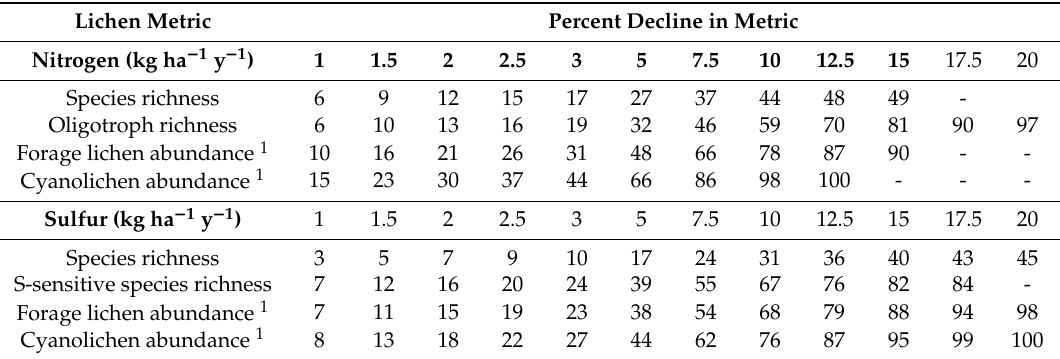
Table 4. Predicted percent declines in lichen metrics with increasing nitrogen and sulfur deposition. – = not modeled, insu ffi cient